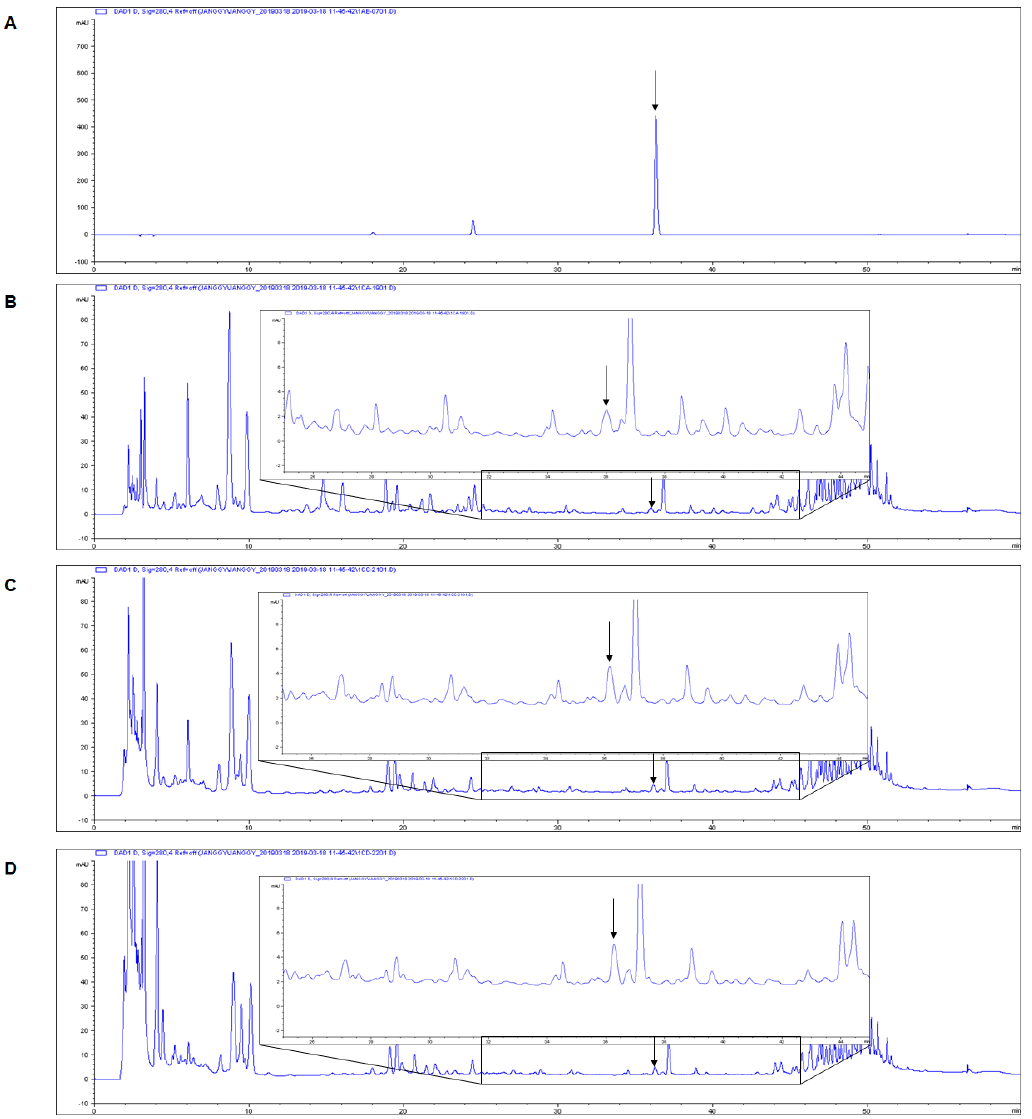
Figure 5. Typical chromatograms of isoliquiritigenin and licorice extracts based on HPLC analysis: ( a ) isoliquiritigenin standard, ( b ) nontreated licorice, ( c ) heat-treated licorice (120 °C), and ( d ) heat-treated licorice (130 °C). HPLC, high-per- formance liquid chromatography. The arrow indicates the isoliquiritigenin peak (36,299 min). Table 3. Total phenolic and isoliquiritigenin content of licorice extracts.